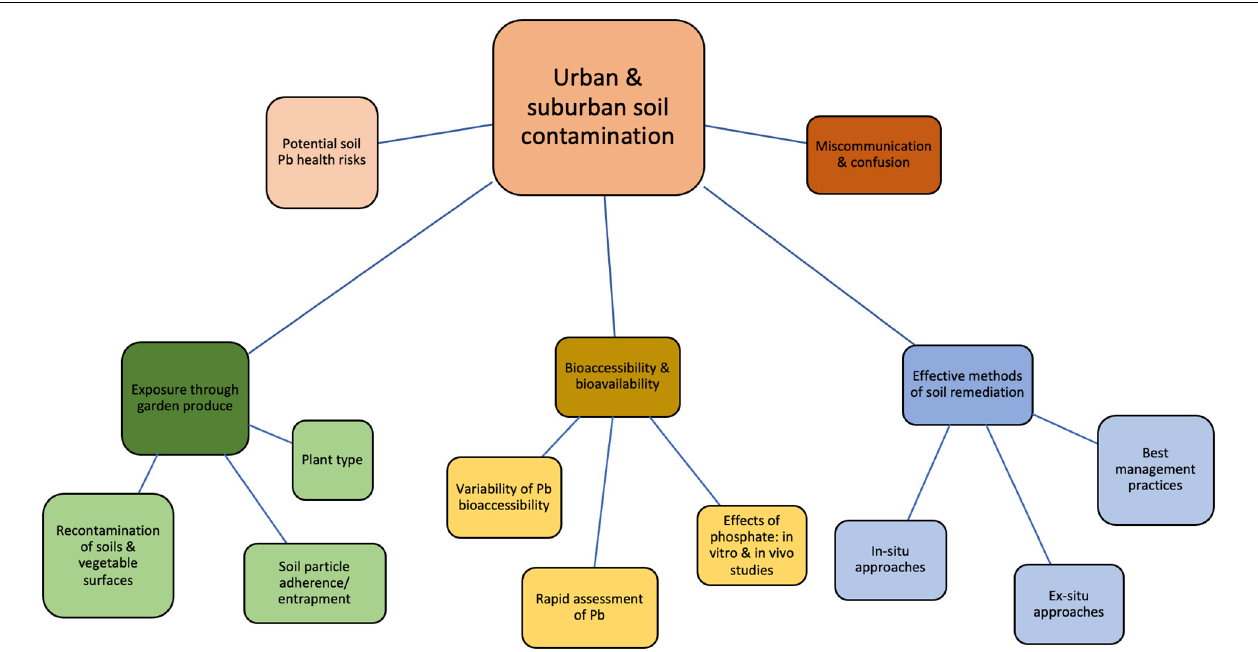
FIGURE 1 | “Road map” to the paper highlighting main